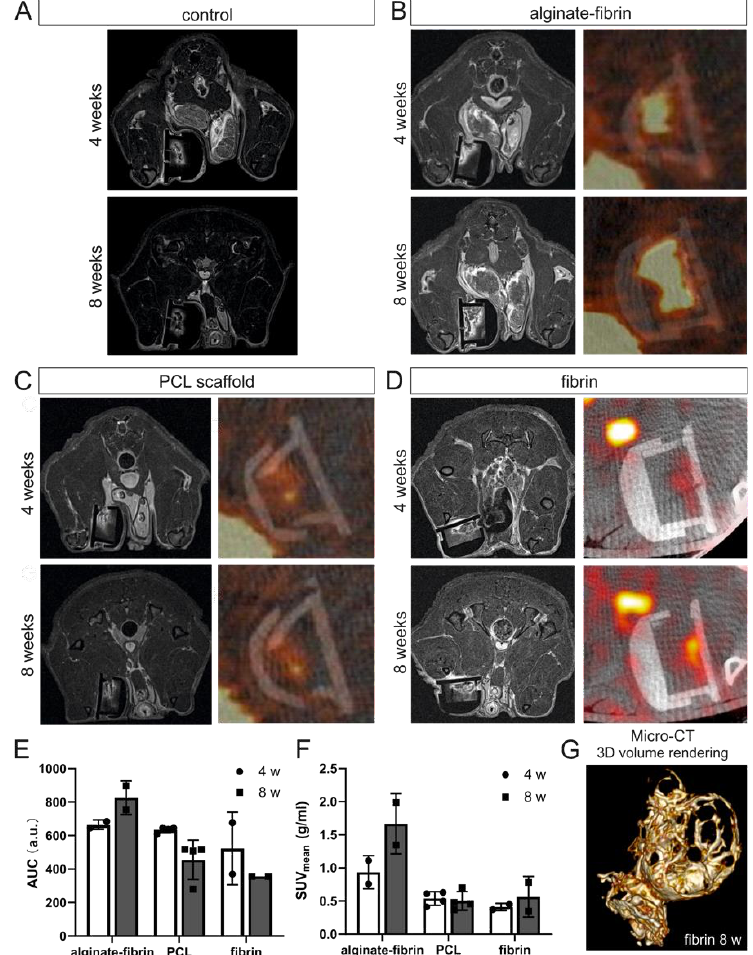
Figure 3. Imaging analysis. Representative MRI and PET-CT imaging in control ( A ), alginate–fibrin ( B ), PCL ( C ), and fibrin ( D ) groups. Yellow arrows indicate the perfused area within the implantation chamber in MRI imaging. White arrows indicate the tracer-avid area formed by tumor in PET-CT imaging. One representative image per group and per time-point is shown. Quantitative analysis of AUC (measured in a.u. arbitrary units) ( E ) and SUV mean ( F ) derived from PET-CT. ( G ) Representative 3D micro-CT images of the microvasculature in fibrin group after perfusion with an intravascular contrast agent (yellow perfused vessels) after 8 weeks